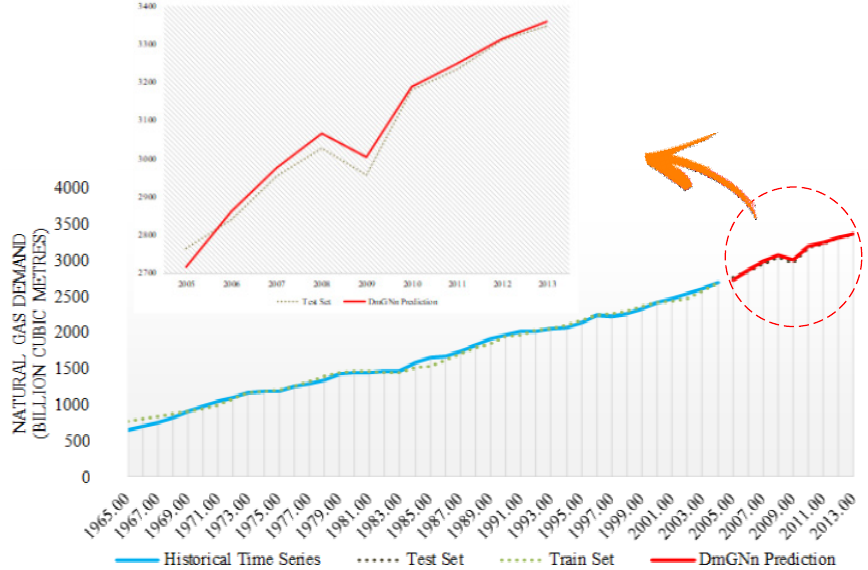
Figure 7. Performance of the proposed DmGNn model for the training and testing data